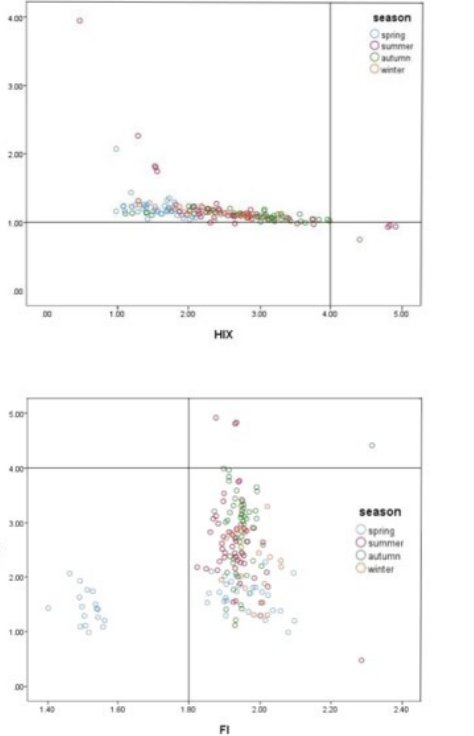
Figure 5. Seasonal variation of the humification index (HIX), biological index (BIX), and fluorescence index (FI) in the water samples of TNRs; a indicates BIX vs. HIX ; b indicates BIX vs. FI ; c indicates HIX vs. FI.